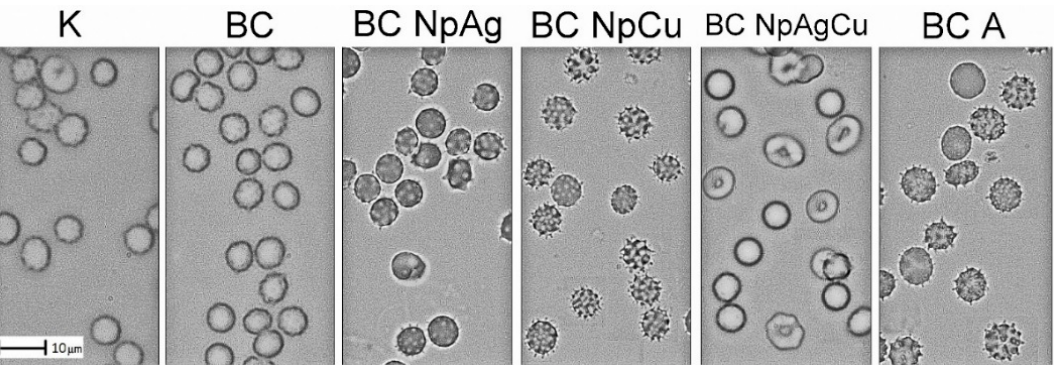
Figure 4. Morphology of RBCSs exposed to cement specimens for 24 h: Modified bone cements with 1.5% w / w of modifiers (the presented pictures are representative for 5 experiments).